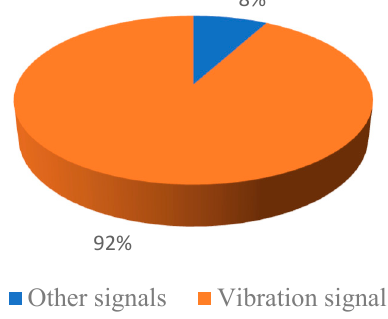
Figure 4. Single signal scale.